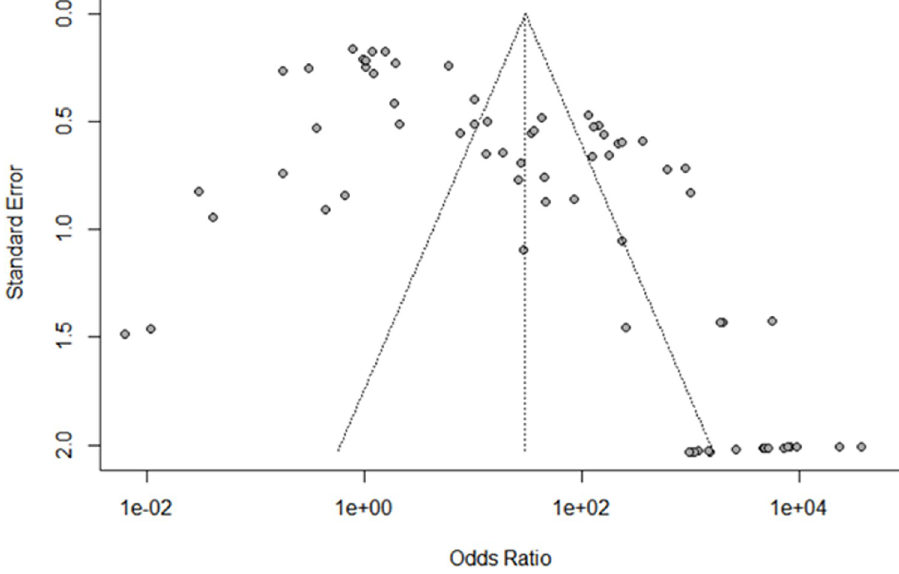
Fig 9. Funnel plot asymmetry test to assess publication bias. Each dot represents an individual study, and the dashed line represents the regression line. P-value = 0.236.